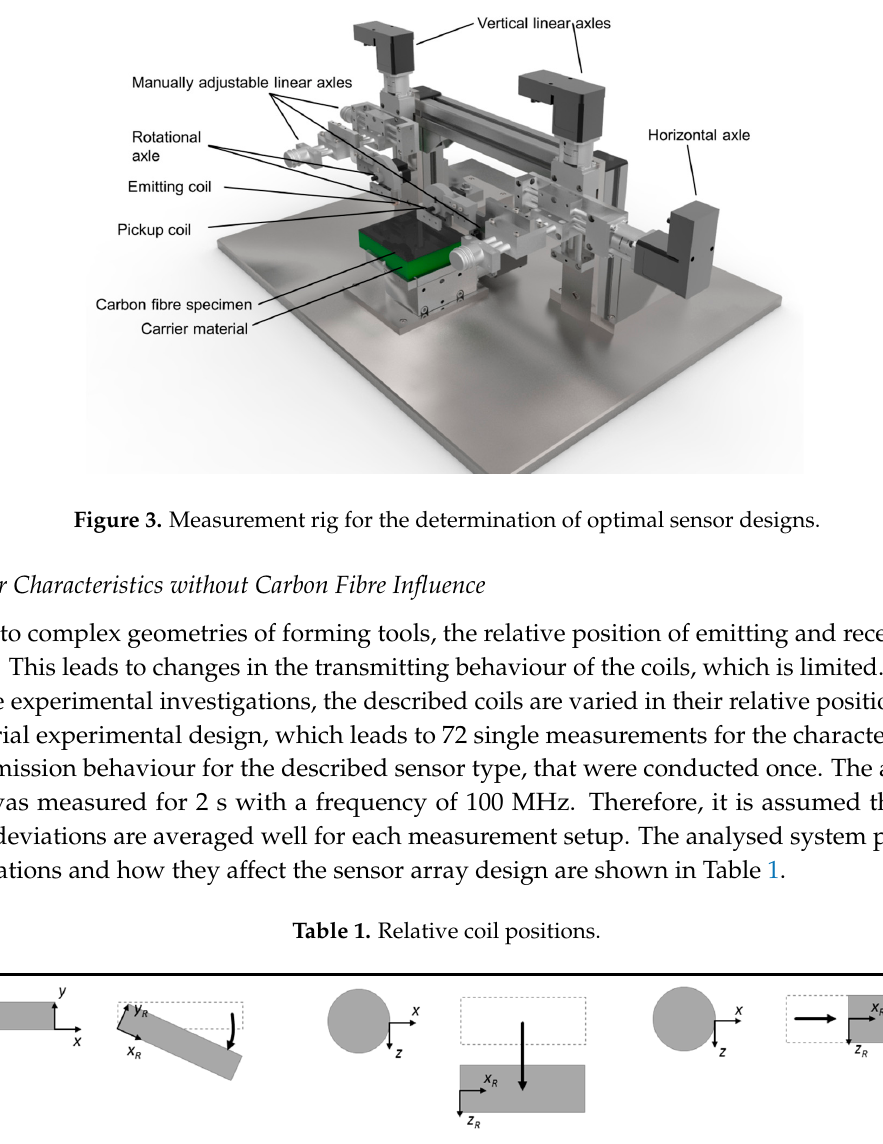
Figure 2. In-process integration of eddy current sensor arrays in preforming tools.